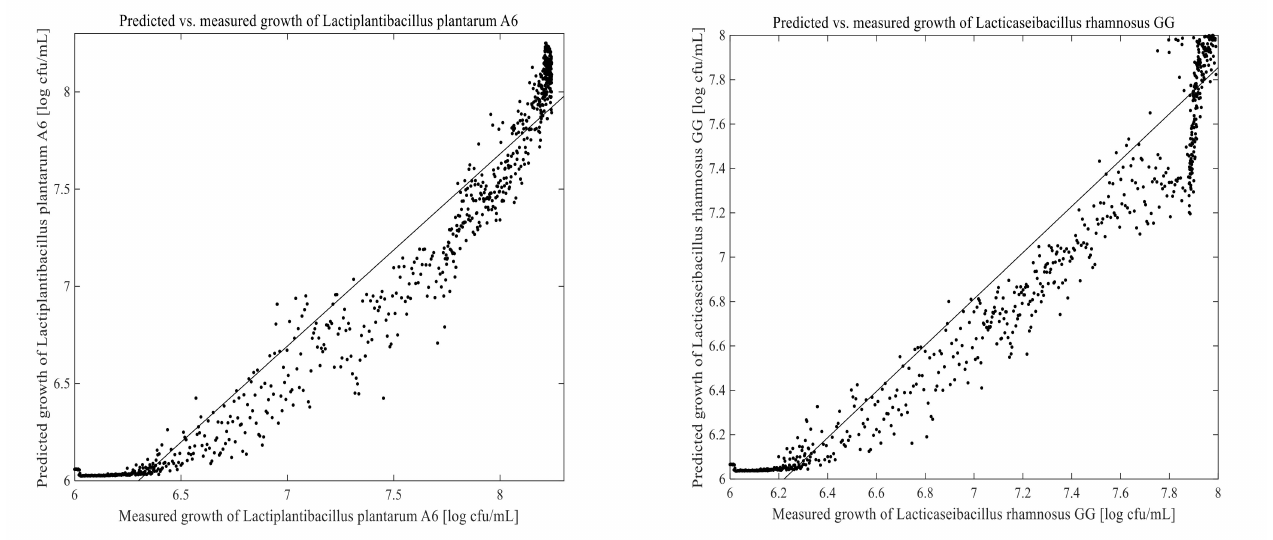
Figure 9. Predicted vs. measured cell growth in the fermentation of 4 g/100 mL of substrate inoculated with mixed strains of 6 log cfu/mL Lactiplantibacillus plantarum A6 and Lacticaseibacillus rhamnosus GG; predicted with artificial neural networks using five hidden